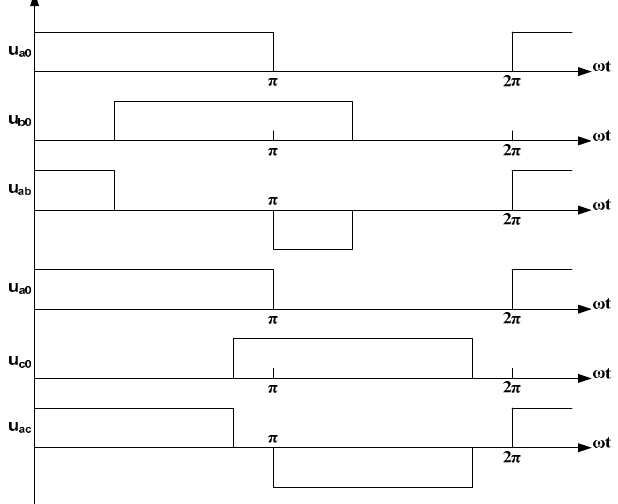
Figure 2. Polar and phase-to-phase voltage: u a 0 , u b 0 , u c 0 , u ab , u ac